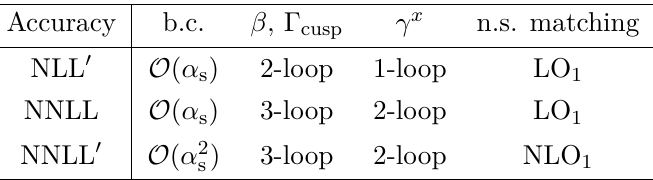
Table 1 . Definition of resummed accuracies in terms of the required perturbative order of the resummation ingredients and of the boundary conditions. The appropriate fixed order matching is also